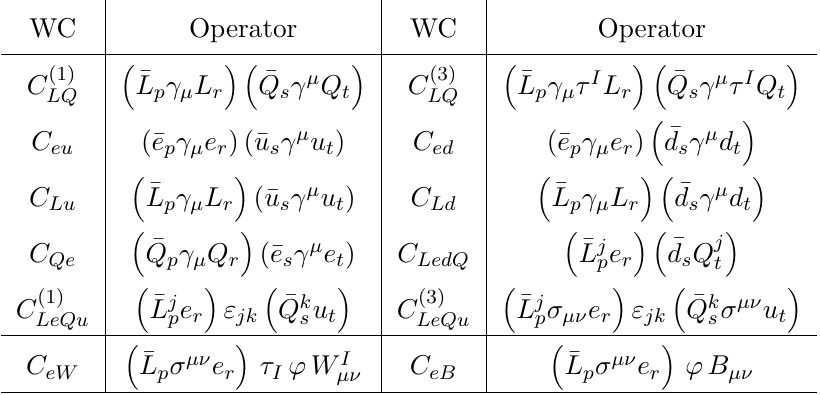
are the Pauli I